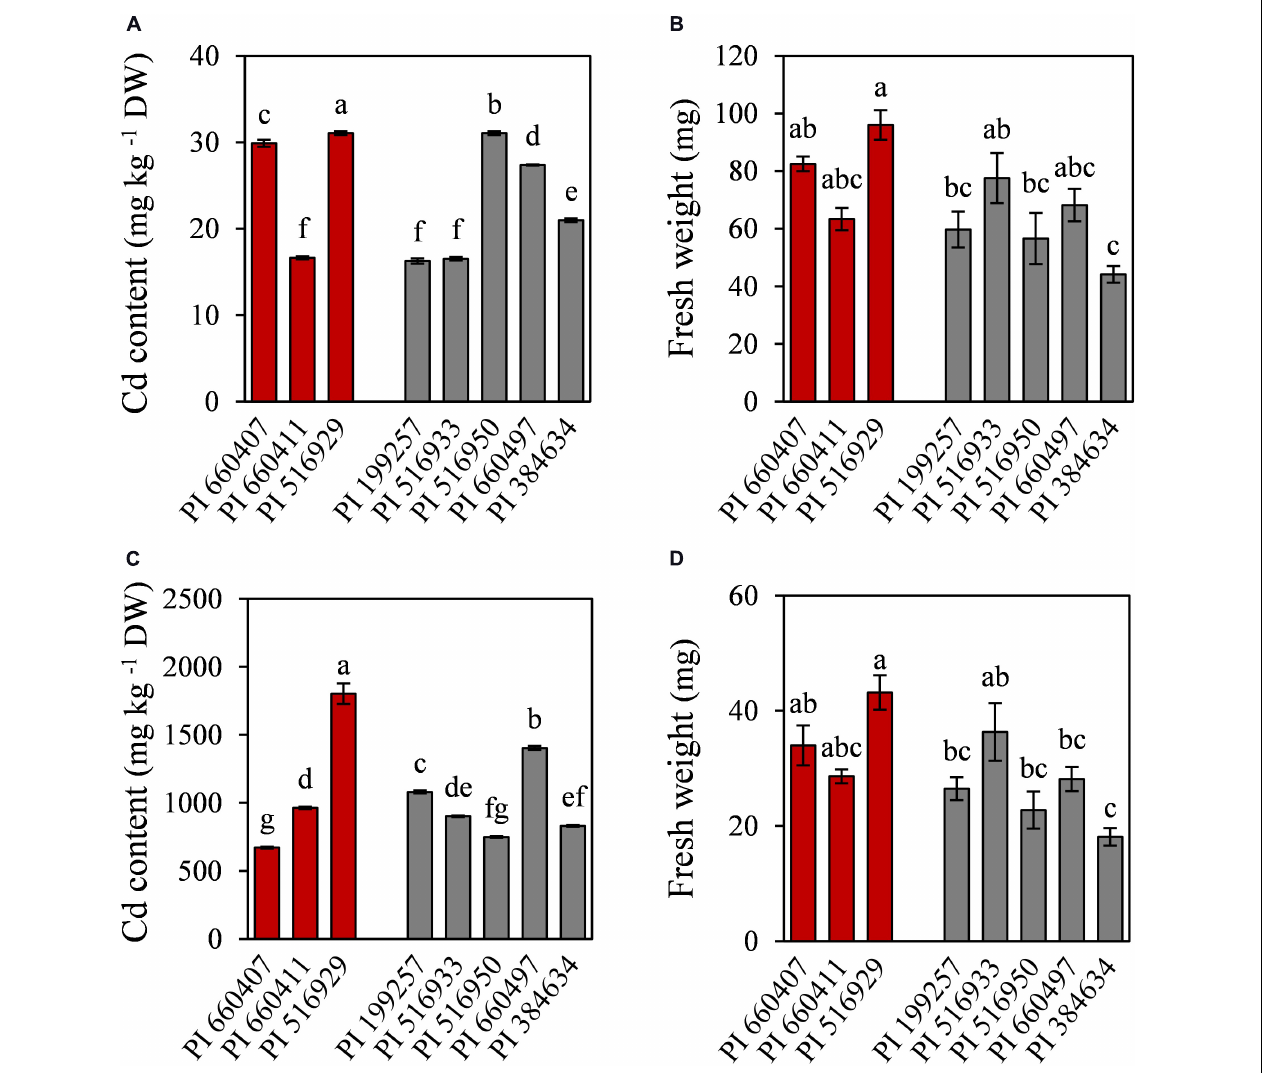
FIGURE 4 | Cadmium content and fresh weight of shoots (A,B) and roots (C,D) of tolerant (red) and sensitive (gray) M. truncatula accessions grown in hydroponic pouches under Cd stress (100 µ M CdCl 2 , 12 days). Mean values ± standard error are indicated, n = 3 for Cd content; n = 5–10 for fresh weight. Different letters indicate significant differences between cultivars (Tukey HSD test, p ≤